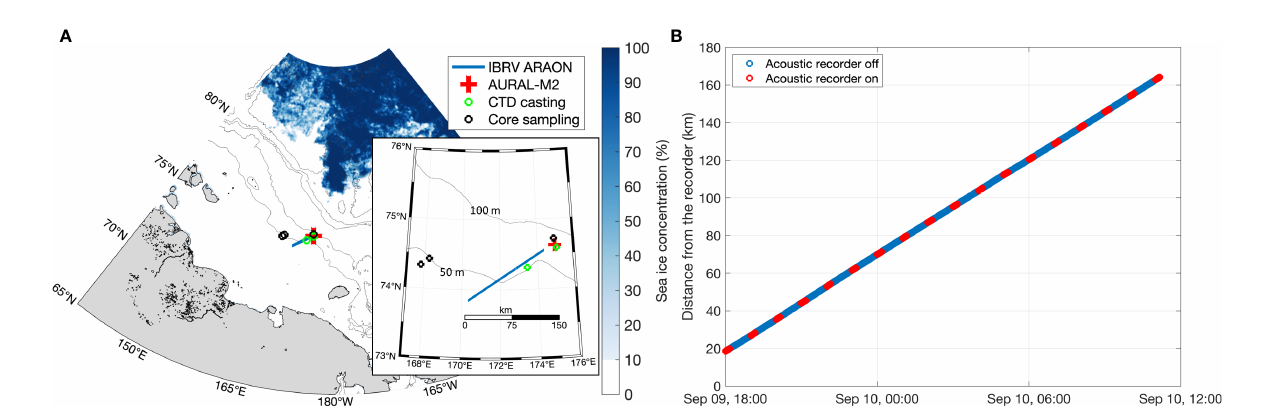
FIGURE 1 (A) Map of the measurement area with the sea ice concentration on 9 September showing the AURAL-M2 mooring location (red cross), seismic survey track (blue line), two CTD casting sites (green circles) and three core sampling sites (black circles). (B) The distance from AURAL-M2 to IBRV ARAON. The distances for 10 minutes every hour when the AURAL-M2 was working are represented by red